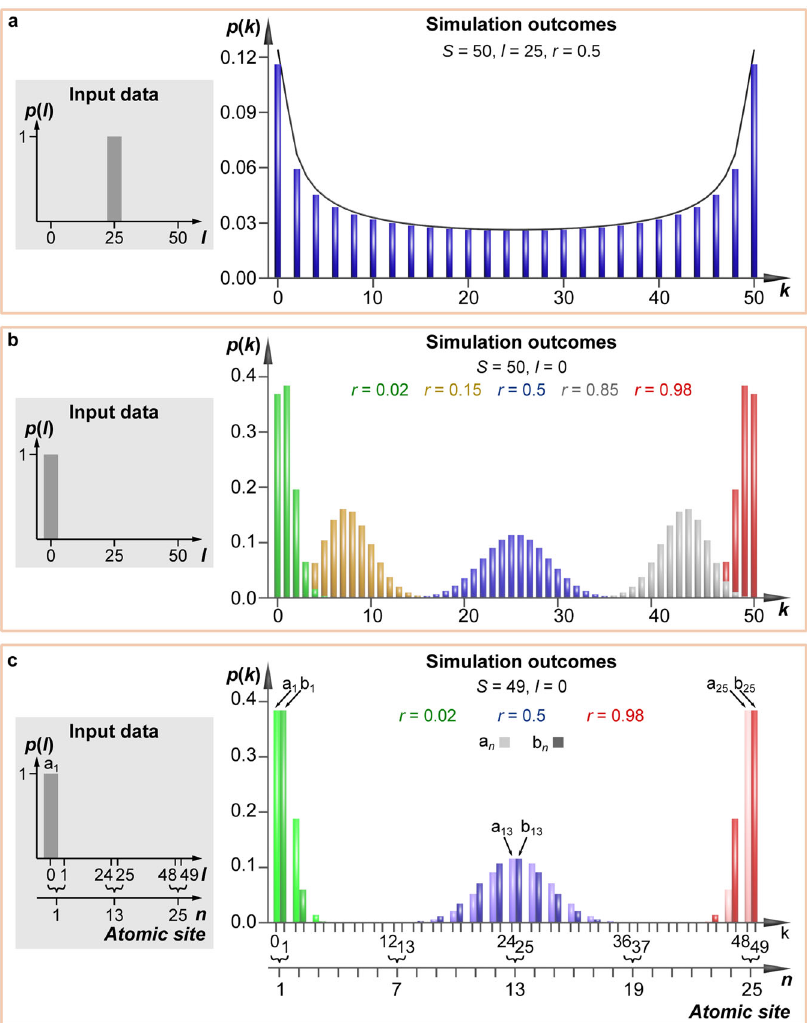
Fig. 2 Encoding the outcomes of quantum simulations in photon statistics. We repeatedly overlap two Fock states on a beam splitter of re fl ectivity r to collect the photon statistics in its exit ports, p ( k ). They directly provide the results of computation carried out by quantum (cid:3) (cid:3) (cid:4) (cid:4) (cid:3) (cid:3) S and r = 0.5, revealing weakly localised edge states with a non-decaying envelope (black line), interference. a The fi rst programme uses S 2 2 a b which closely resemble topological states in a non-linear SSH model. b The second programme is run for 0 j i demonstrating that perfect quantum wave packet transfer in a linear register results from mirror re fl ection of the input state w.r.t. the register centre. c For an odd S , this programme additionally simulates the perfect transfer of Majorana fermions a n and b n in a p-wave superconductor over S þ 1 atomic sites. The bars located at even k (light green, blue, and red) correspond to the mode a n with n = k /2 + 1, while those located at 2 odd k (dark green, blue, and red) to the mode b n with n = ( k +